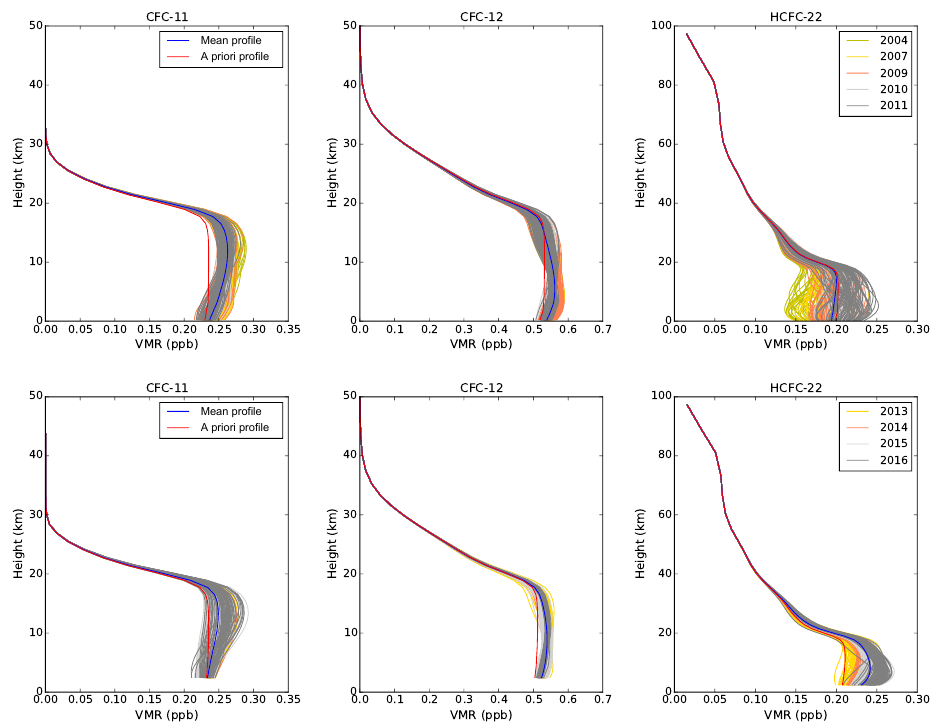
Figure 3. The a priori (red line), retrieved profiles (each year with a different color) and the mean retrieved profile (blue line) of CFC-11, CFC-12 and HCFC-22 at St Denis (upper panels) and Maïdo (bottom panels).